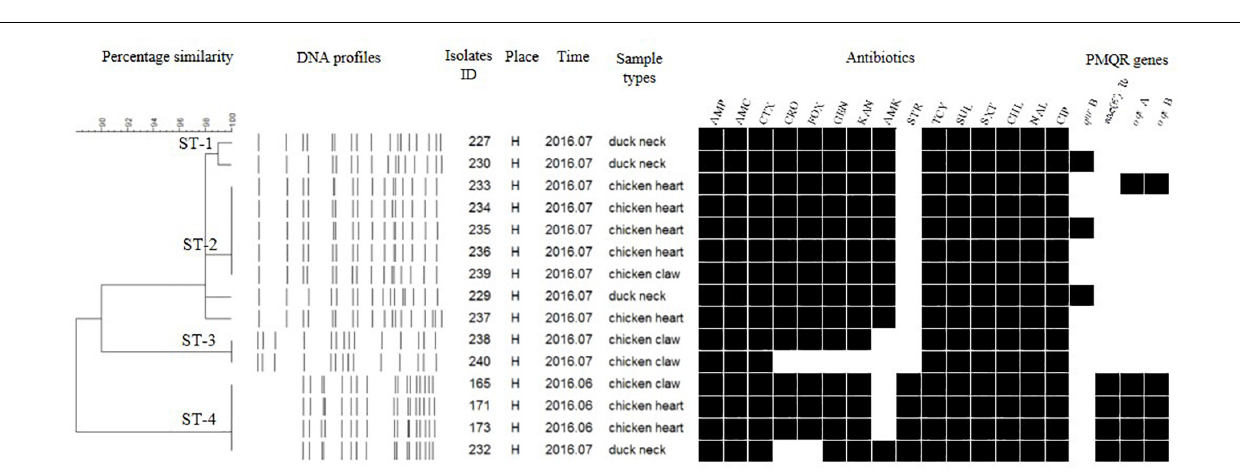
FIGURE 4 | Dendrogram of PFGE profiles for 15 S. Typhimurium isolates, their antibiotic resistance, and PMQR genes. Antibiotics: Ampicillin (AMP), Amoxicillin-clavulanic acid (AMC), Ceftiofur (CTX), Ceftriaxone (CRO), Cefoxitin (FOX), Gentamicin (GEN), Kanamycin (KAN), Amikacin (AMK), Streptomycin (STR), Tetracyclines (TCY), Sulfisoxazole (SUL), Trimethoprim/sulfamethoxazole (SXT), Chloramphenicol (CHL), Nalidixic acid (NAL), and Ciprofloxacin